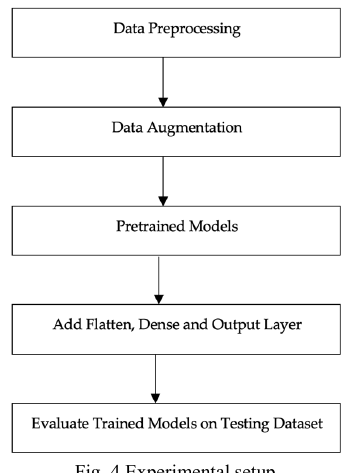
Fig. 4 Experimental